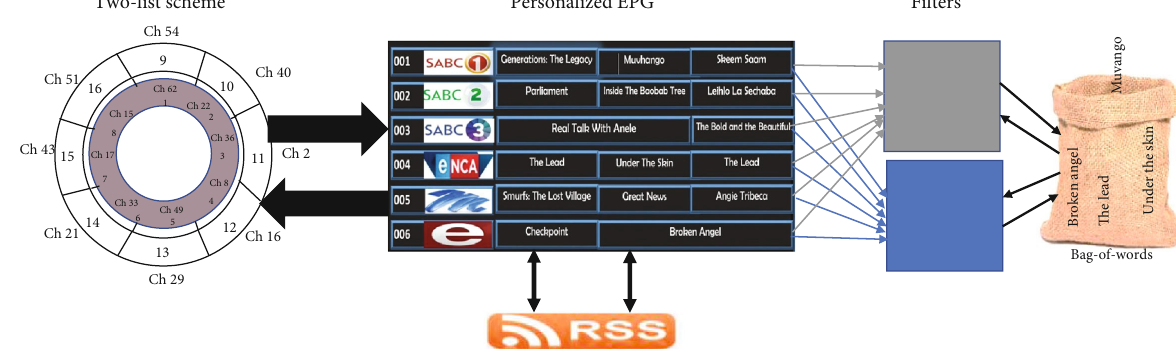
Figure 1: Adaptive channel